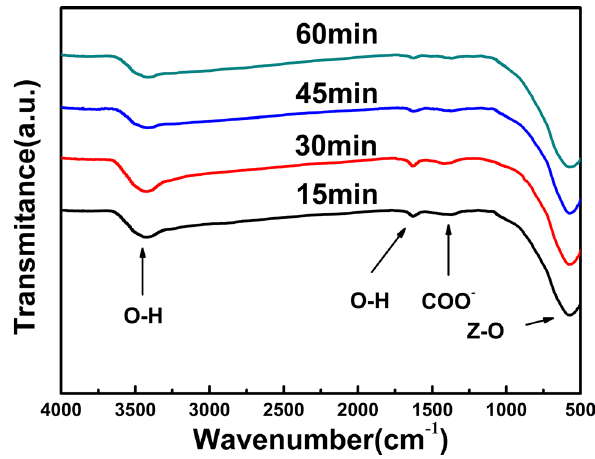
Figure 2. FTIR spectra of BCZT powders synthesized at 180 °C for various reaction time.